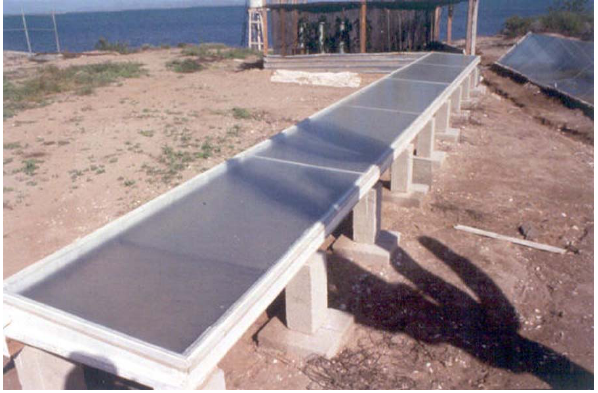
Figure 13. Long channel shallow solar still.